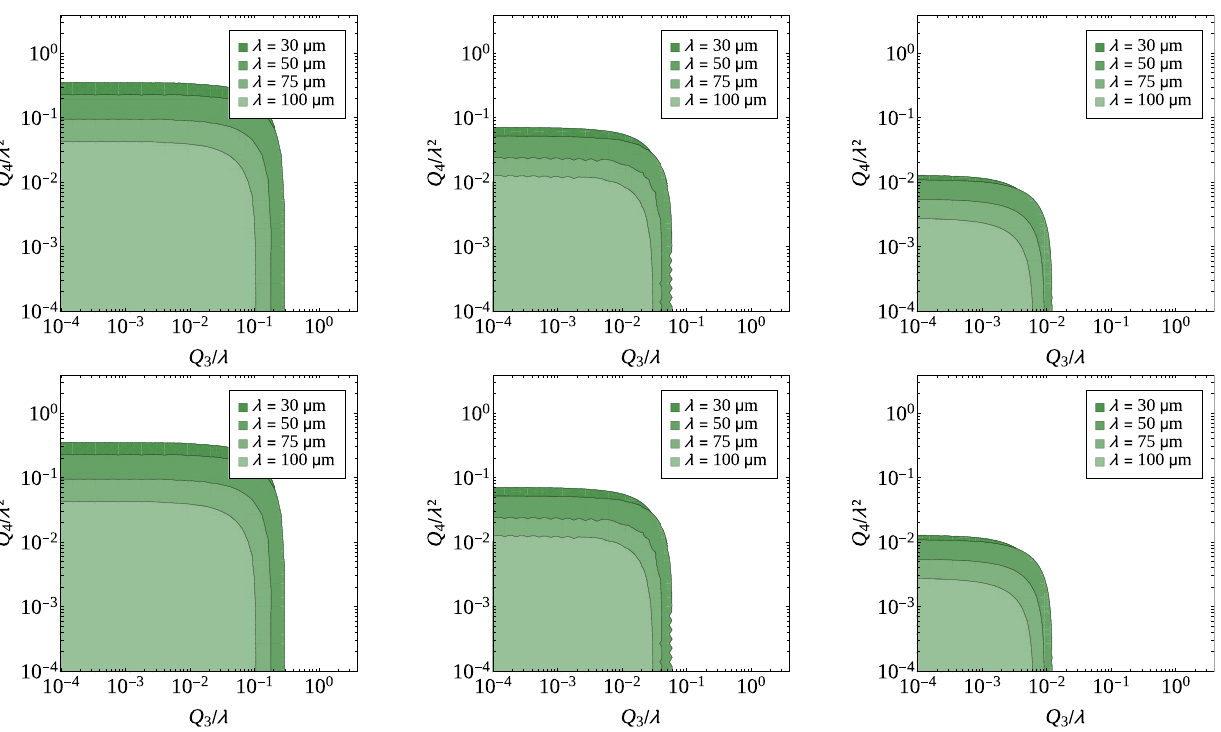
Fig. 13 Values of background sources Q 3 and Q 4 (green shaded regions) for which the precession induced by the mN-potential differs from that induced by the BN-potential, for specific points of the ( λ,α ) plane, by a value larger than twice the clock precision (2 s). Within this region we could claim that any observation of precession would be due to New Physics and not to large background sources. From left to